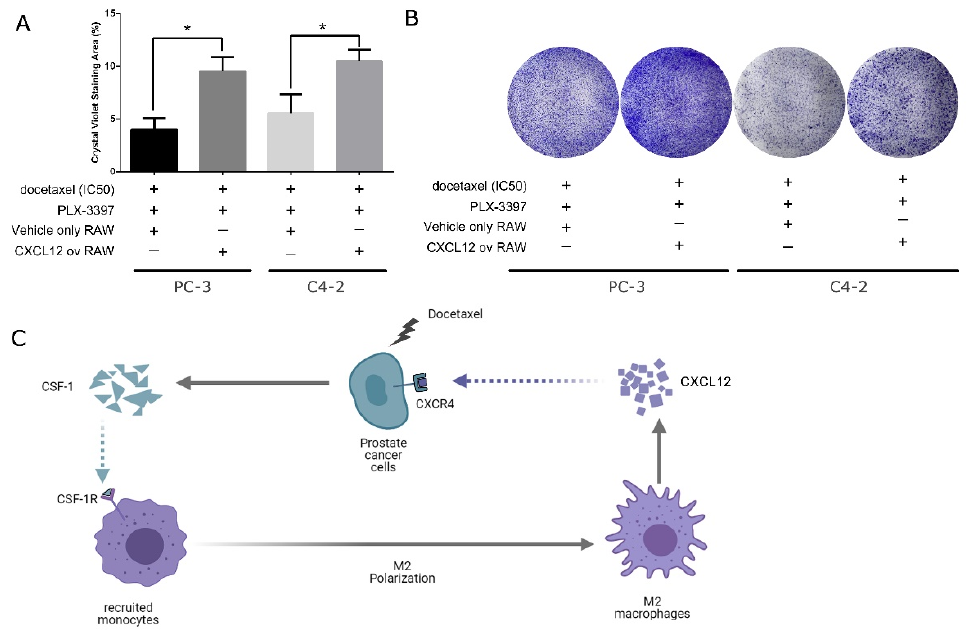
Figure 4. Overexpression of CXCL12 in macrophages can negate the effect caused by CSF-1R inhibition from pexidartinib. ( A ) Upon artificial expression of CXCL12 in RAW cells, RAW cells can prevent the resensitization of CSF-1R inhibition caused by pexidartinib in both PC-3 and C4-2 cells. ( B ) Representative images of colony formation assay stained by crystal violet. ( C ) Diagram describing the crosstalk of polarized macrophages and castration-resistant prostate cancer cells in response to docetaxel treatment. All treatment durations were 48 h before cell seeding in the colony formation assay, and experiments were repeated three times. *: p < 0.01; ov: overexpressing.